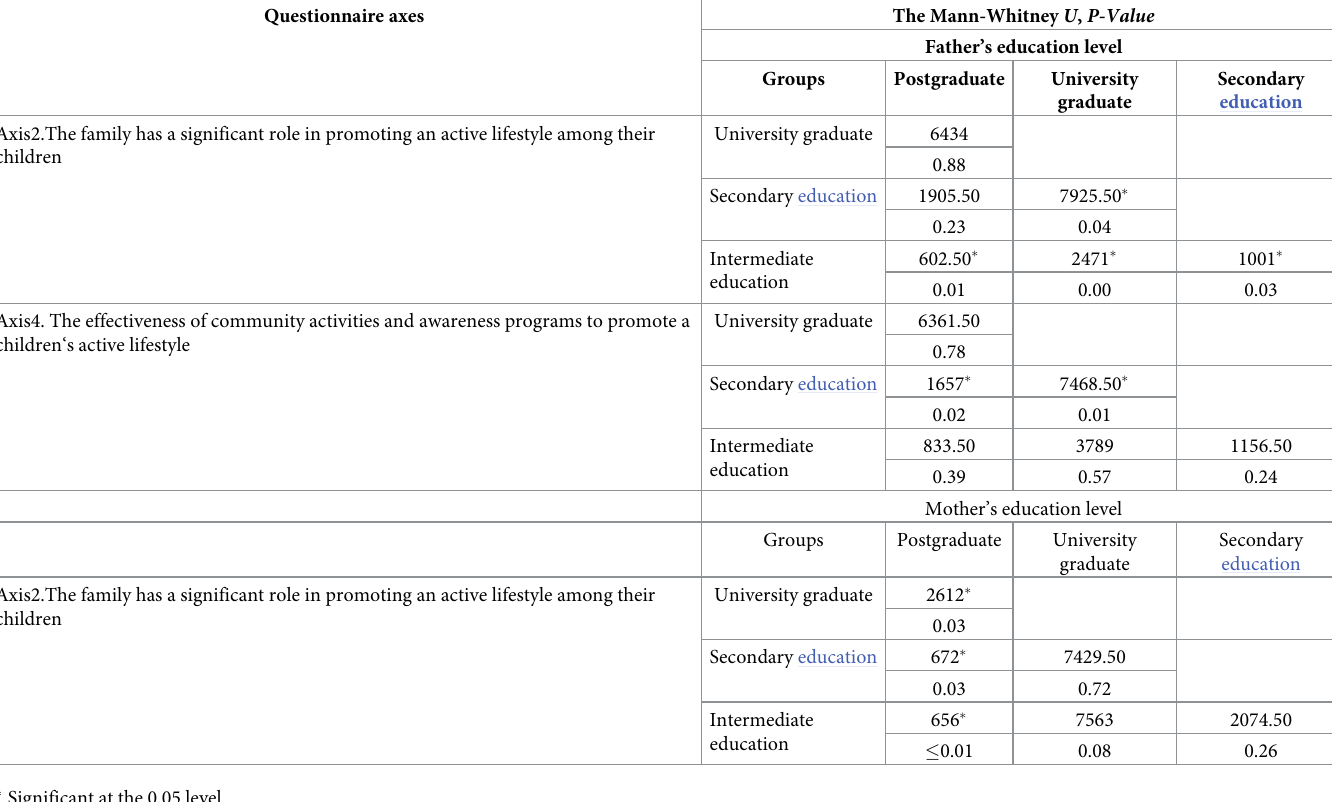
Table 7. The Mann-Whitney test to determine the significant difference in the mean of sample‘s responses among each pair group according to Parent‘s education level. Questionnaire